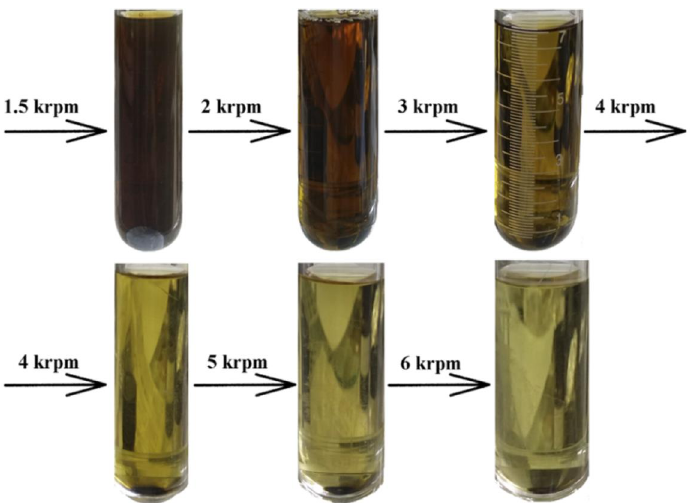
Figure 12. The LCC method used to separate the nanosheets. Reproduced with permission from [98].